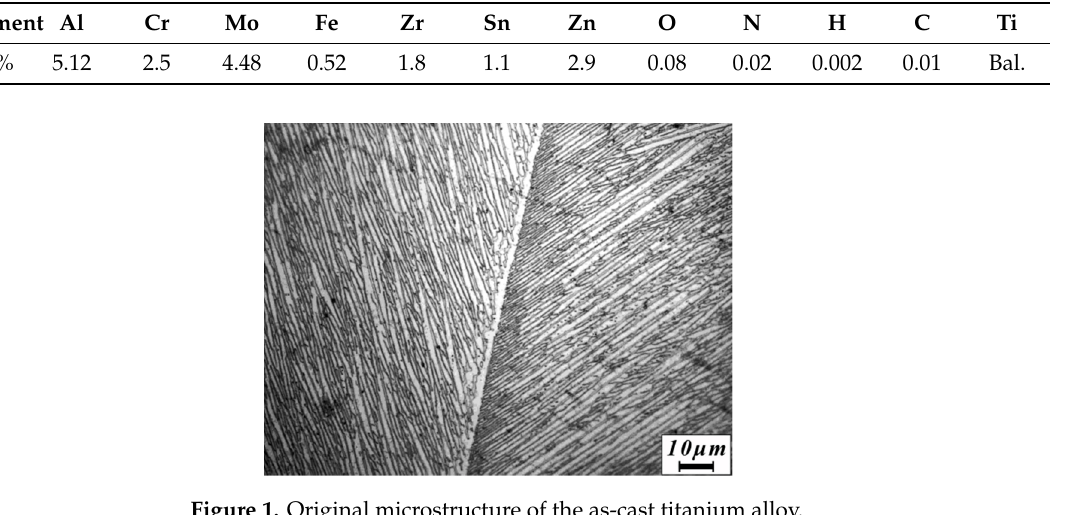
Table 1. Composition of the original titanium alloy (wt %).